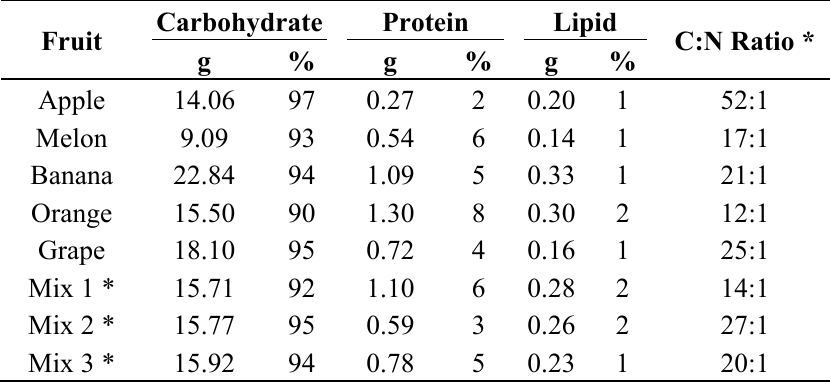
Table 8. Nutrient composition in 100 g of